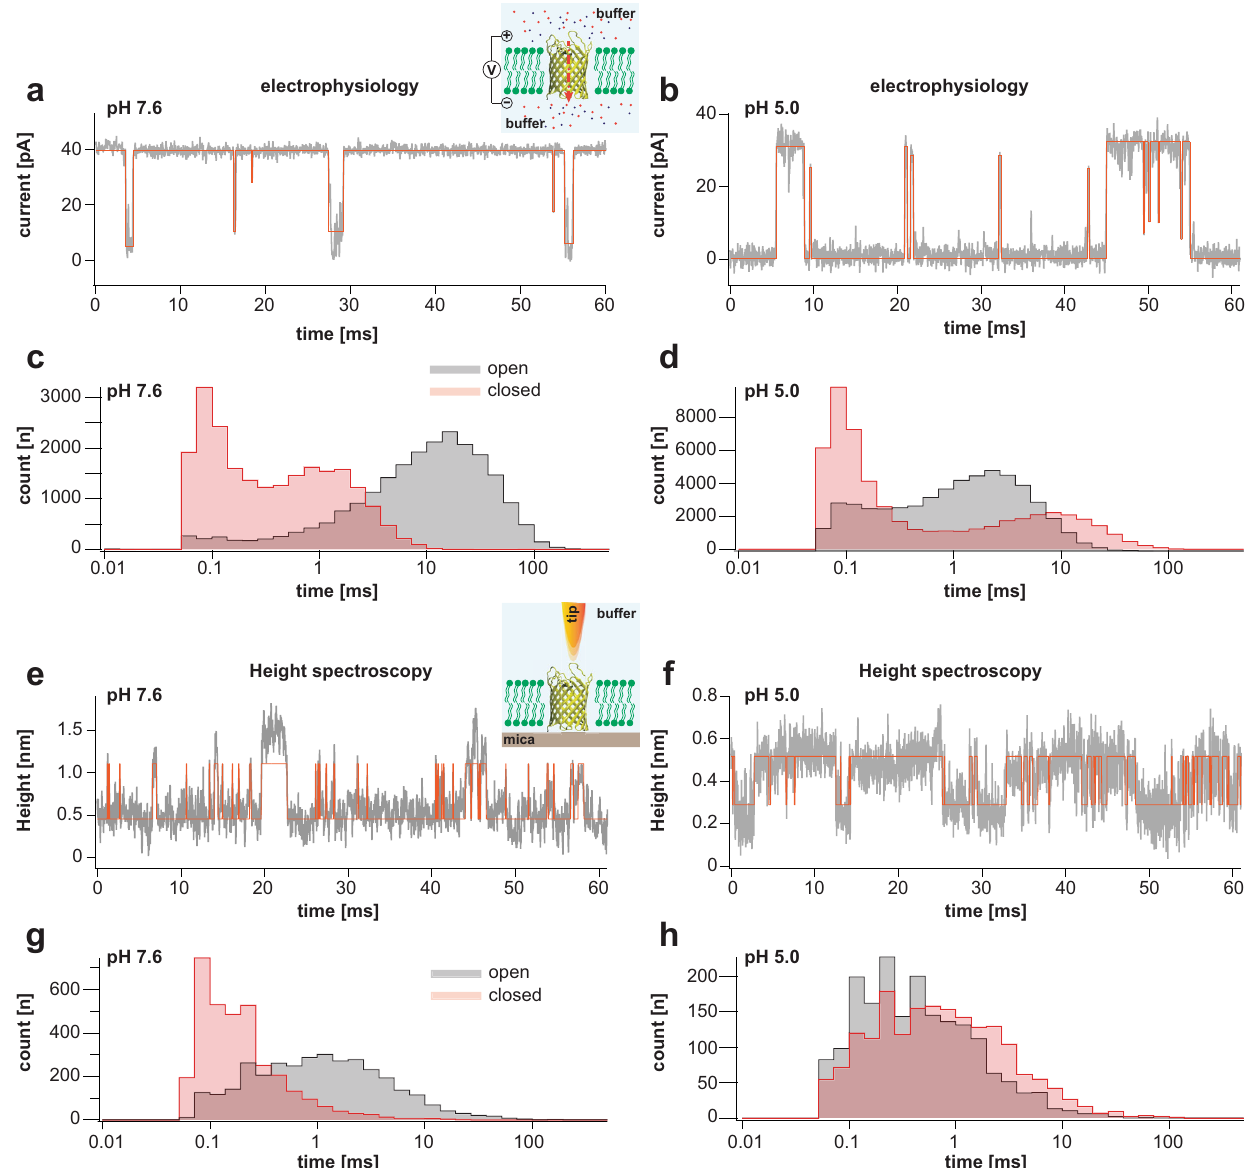
Fig. 2 Single channel electrophysiology and HS-AFM height spectroscopy recordings of OmpG in lipid bilayers. Representative 60-ms segments of OmpG single channel recordings at pH 7.6 ( a ) and pH 5.0 ( b ) at + 40 mV membrane potential (longer traces in Supplementary Figs. 2 and 3). Cartoon representation of single channel recording experimental setup is shown in inset of ( a ). OmpG (yellow) in open state (PDB:2IWV) is placed in a lipid bilayer (green) surrounded by buffer (light blue shade) and potassium and chloride ions are shown as red and blue spheres. Red arrow indicates ion fl ow through OmpG in response to voltage application. Dwell time histograms of open and closed states at pH 7.6 ( c ) and pH 5.0 ( d ) from single-channel recordings (see Supplementary Table 1). Representative 60-ms segments of OmpG HS-AFM-HS recordings at pH 7.6 ( e ) and pH 5.0 ( f ) (longer traces in Supplementary Fig. 4). Cartoon representation of HS-AFM height spectroscopy experimental setup is shown in inset of ( e ). An oscillating AFM tip (orange) detects conformational changes of loop motion. Dwell time histograms of open and closed states at pH 7.6 ( g ) and pH 5.0 ( h ) from HS-AFM-HS recordings (Supplementary Table 2). In HS-AFM-HS the low state represents the open state, where the HS-AFM tip can descend into the β -barrel, and the high state represents the closed state, where loop-6 covers the beta barrel barring access of the HS-AFM tip to the cavity. All current-time and height-time traces were fi ltered at 20 kHz during analysis. The state dwell-time histograms are shown using log binning for better visualization of the components 49 . Red traces in ( a ) and ( b ) represent idealized current-time traces using clamp fi t software. Red traces in ( e ) and ( f ) represent idealized height-time traces using the STaSI algorithm (see